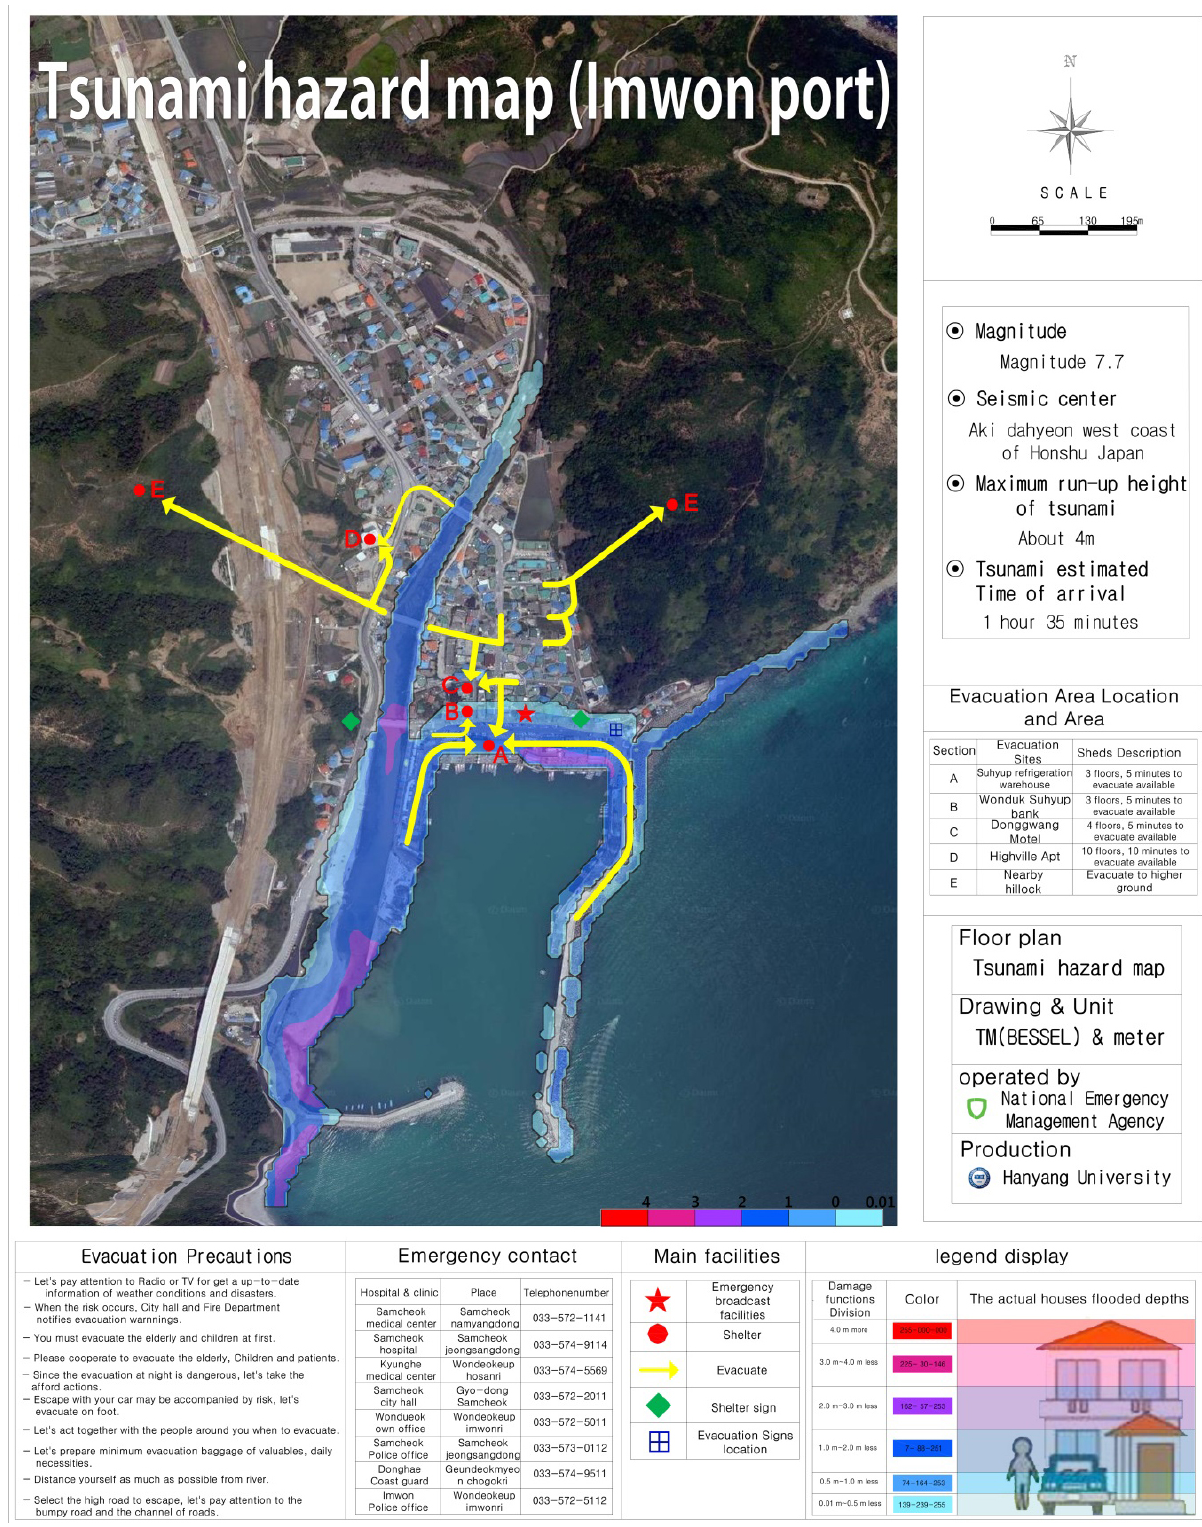
Figure 5. Tsunami hazard map at Imwon